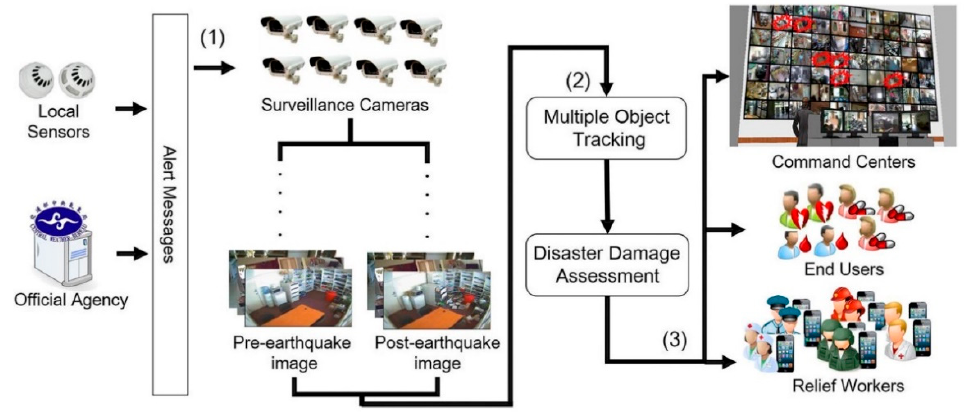
Figure 13. A use scenario of IDEAS. Source: [47] Figure 1, page 1725.